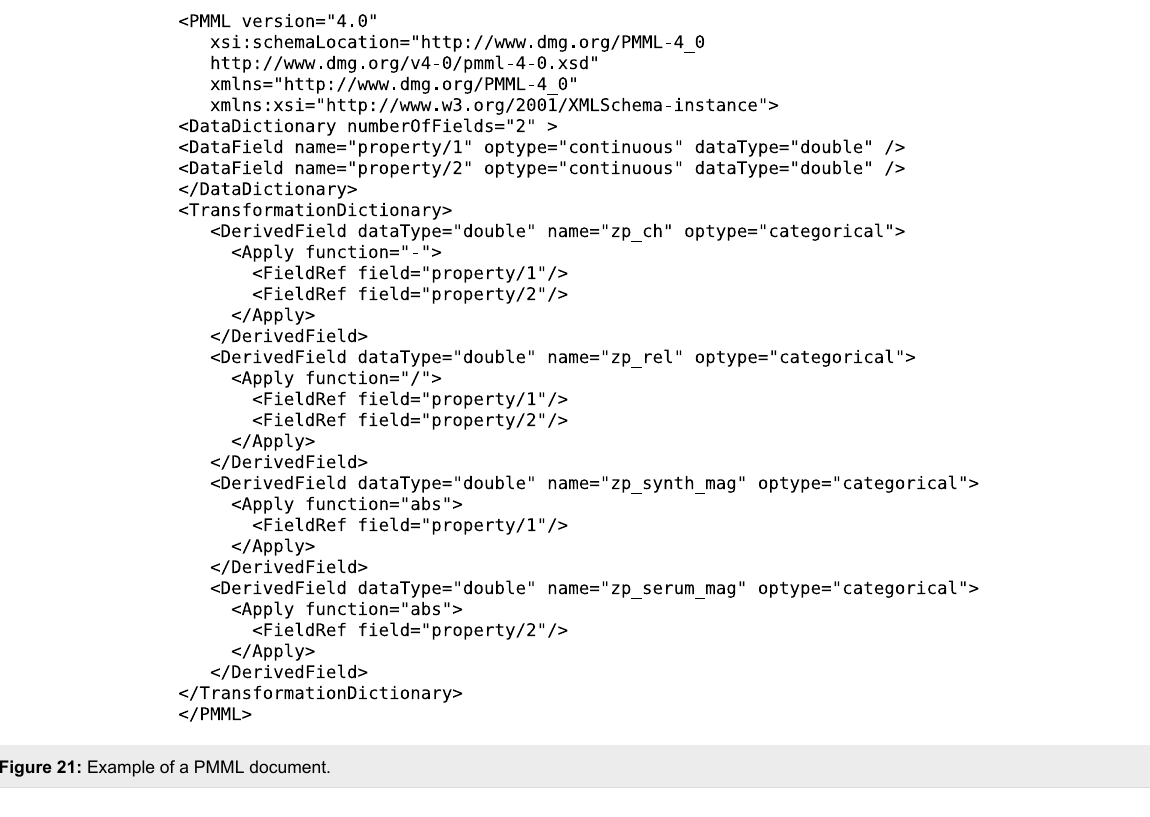
little engagement with intricate software development and allows algorithm developers to outsource their implementations nity through the eNanoMapper framework.